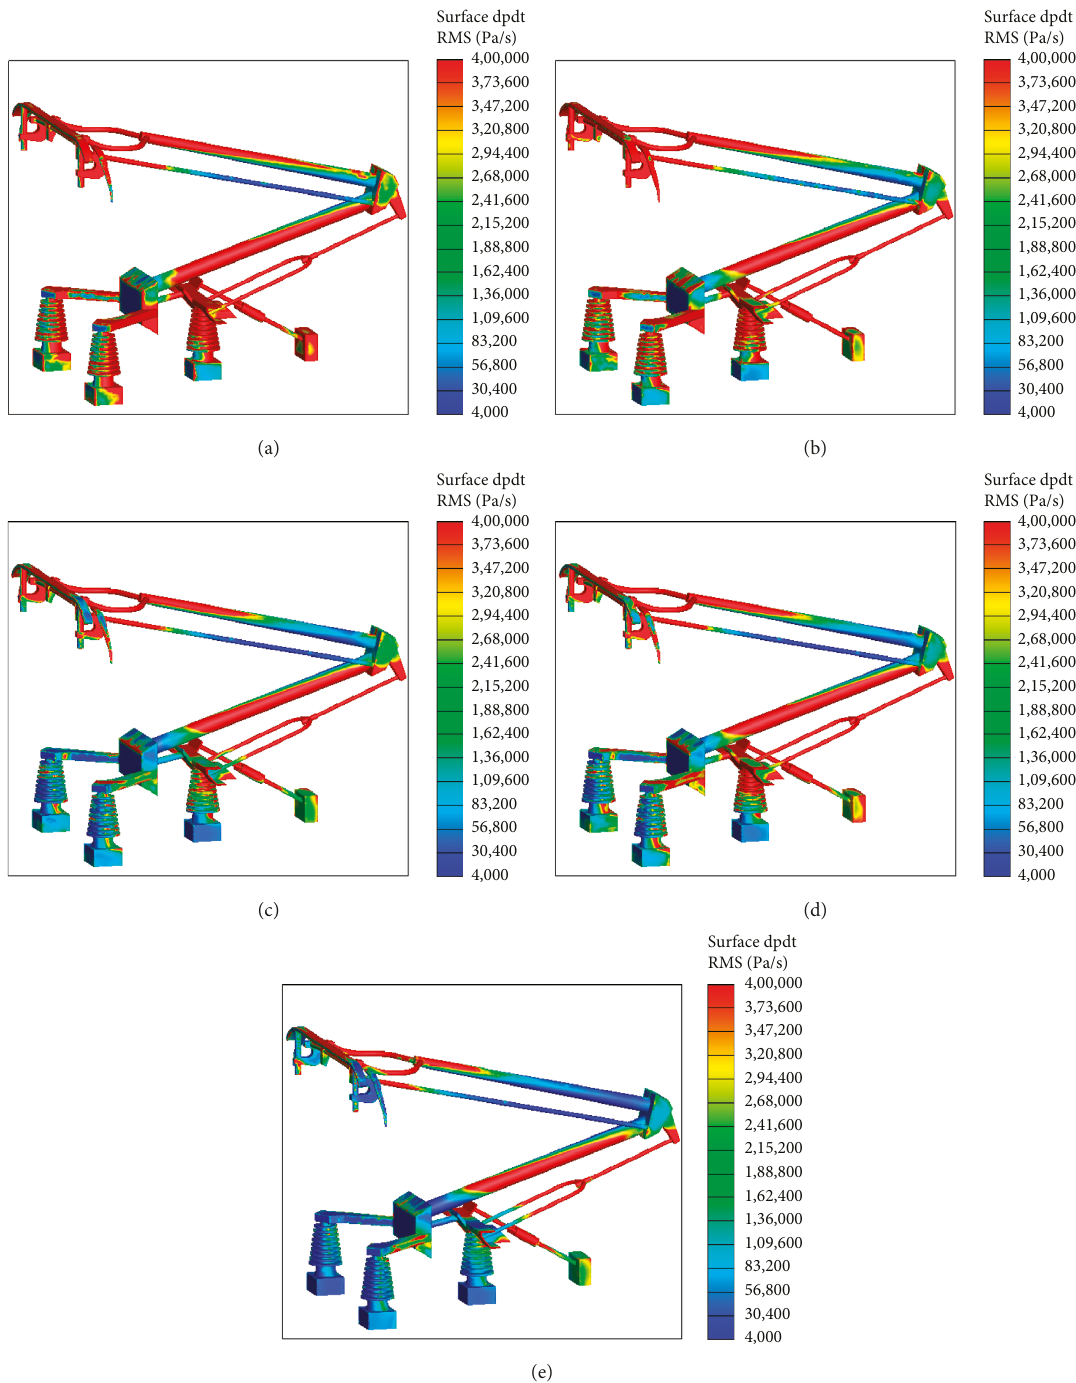
Figure 13: Distribution contours of p